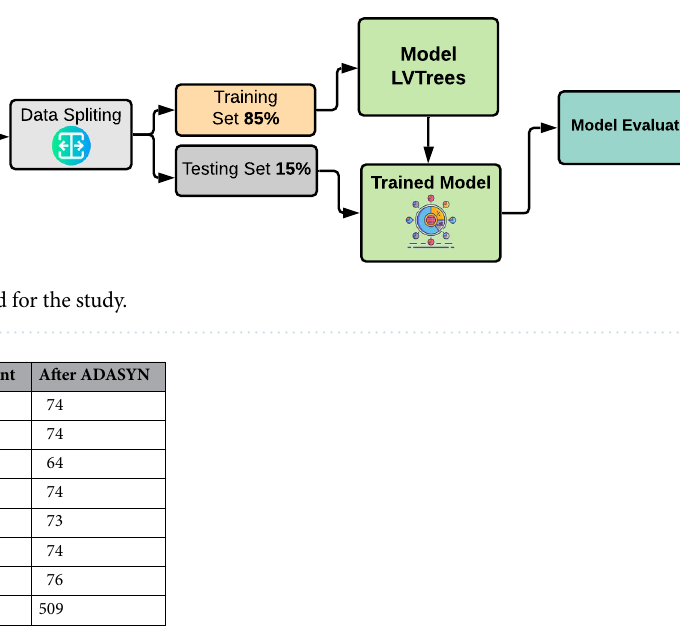
Table 2. Number of samples for each class with and without applying ADASYN technique.